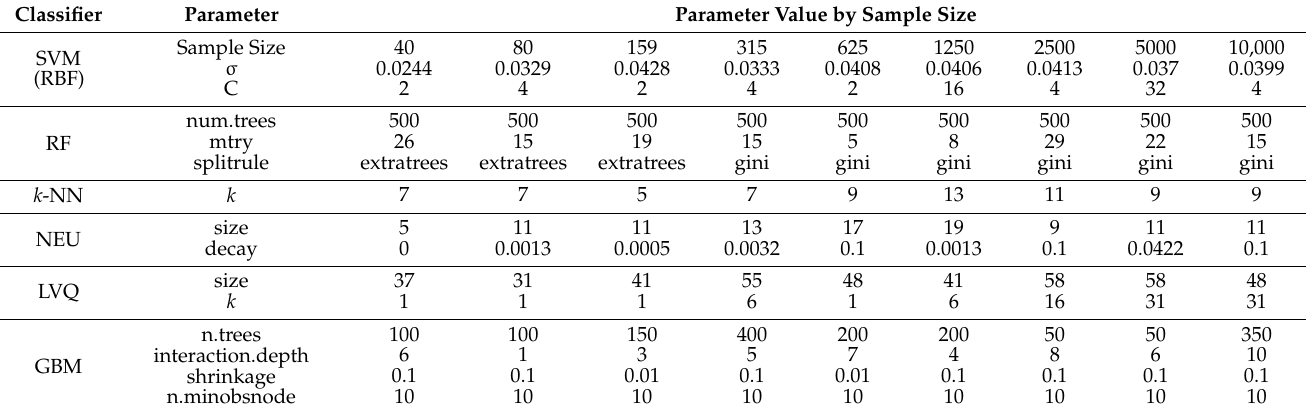
Table 6. Example set of estimated optimal parameters for SVM, RF, k -NN, NEU, LVQ, and GBM